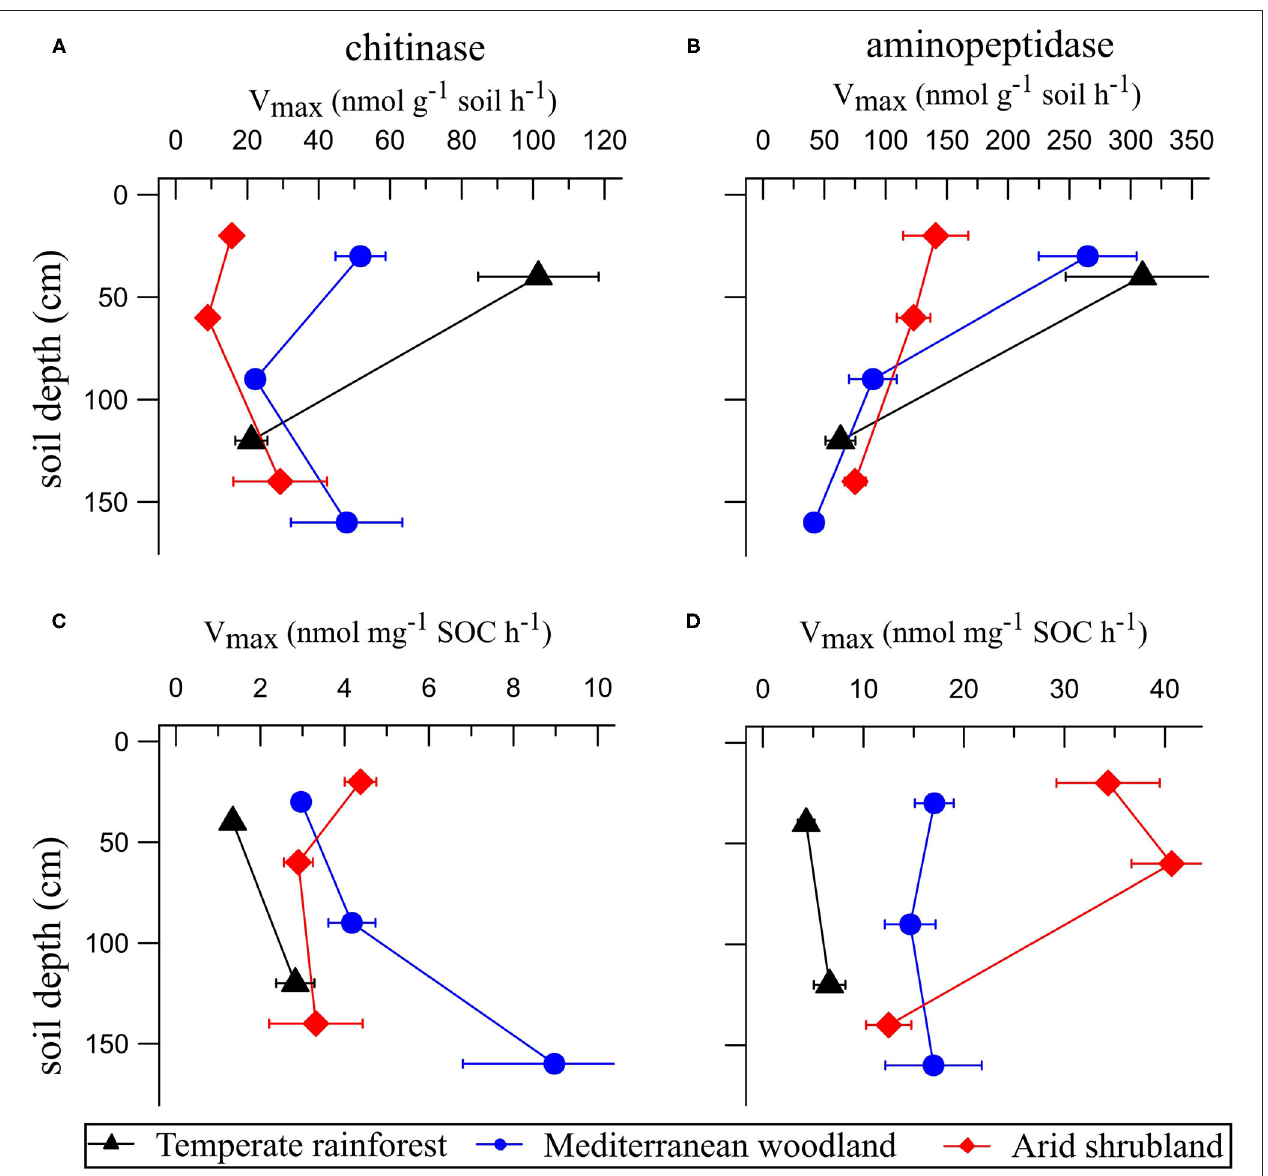
FIGURE 3 | Extracellular enzyme activities (V max ) of chitinase and aminopeptidase per g of soil (A,B) and standardized per unit of SOC (C,D) . Data are presented as means ( n = 4) with standard errors.